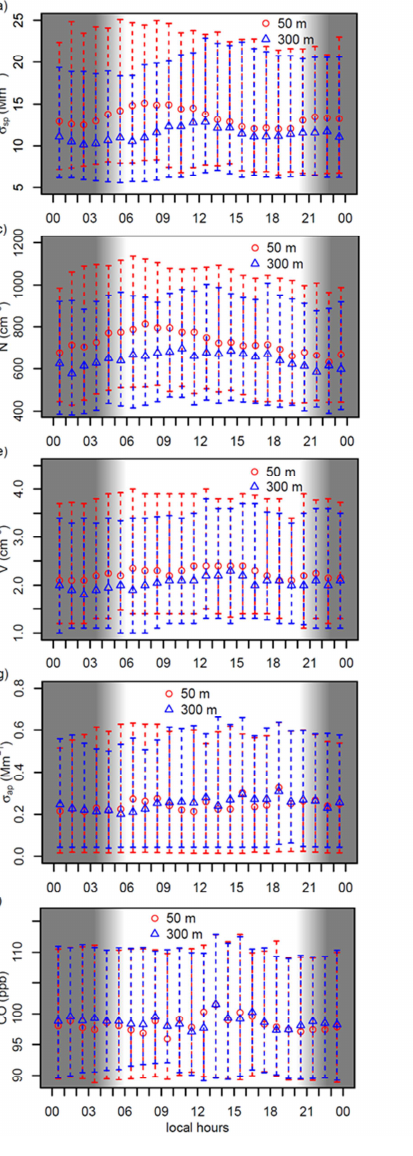
Figure 4: Diurnal variation of a-b) aerosol scattering coefficients, c-d) total number concentration, and e-f) total vol- ume concentration: a, c, e) give absolute concentration and b, d, f) are normalized concentration (hourly value divided Fig. 4. Diurnal variation of (a–b) aerosol scattering coefficients, (c–d) total number concentration, and (e–f) total volume concentration: (a, by daily mean value). Diurnal variation of g-h) aerosol absorption coefficients, and i-j) CO mixing ratio: g, i) for 5 c, e) give absolute concentration and (b, d, f) are normalized concentration (hourly value divided by daily mean value). Diurnal variation of summer and h, j) for winter. (g–h) aerosol absorption coefficients, and (i–j) CO mixing ratio: (g, i) for summer and (h, j) for